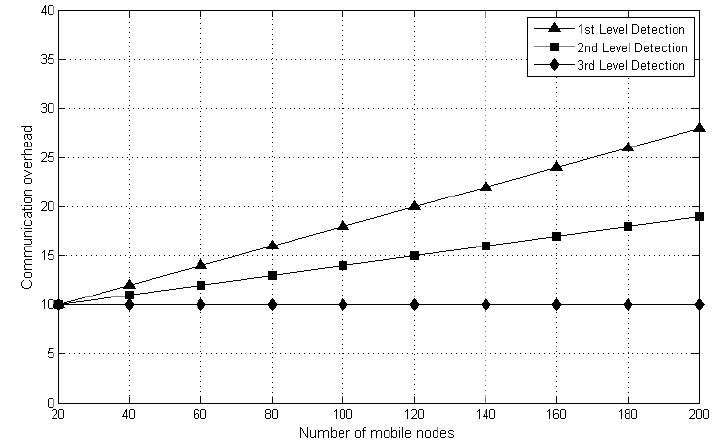
Figure 7. Communication overhead of Danger Theory (DT)